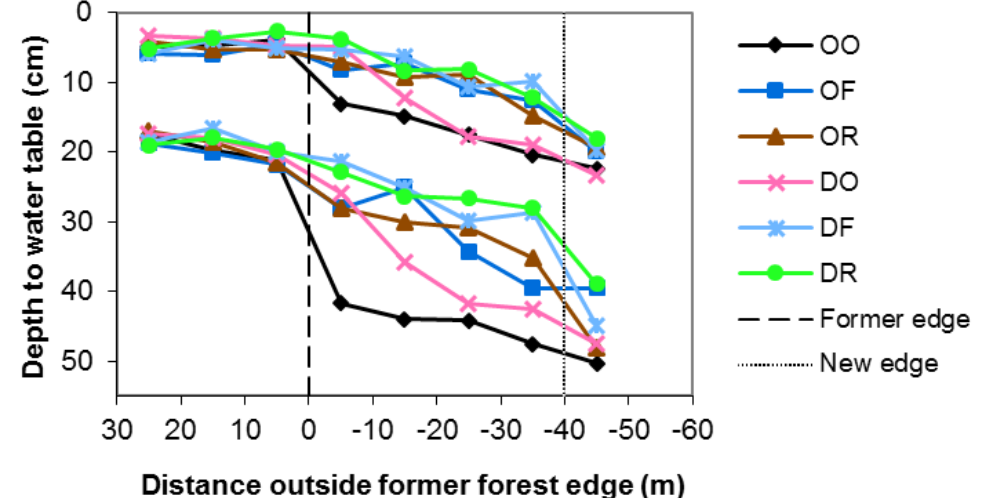
Figure 4. Mean depth to water table for each treatment ten years after restoration on a transect from open bog (left), across the treatment plot and into the adjacent forest (right). The upper set of lines is for the reading following the wettest period (02 Nov 2006) and the lower set is for the reading following the driest period (04 Jly